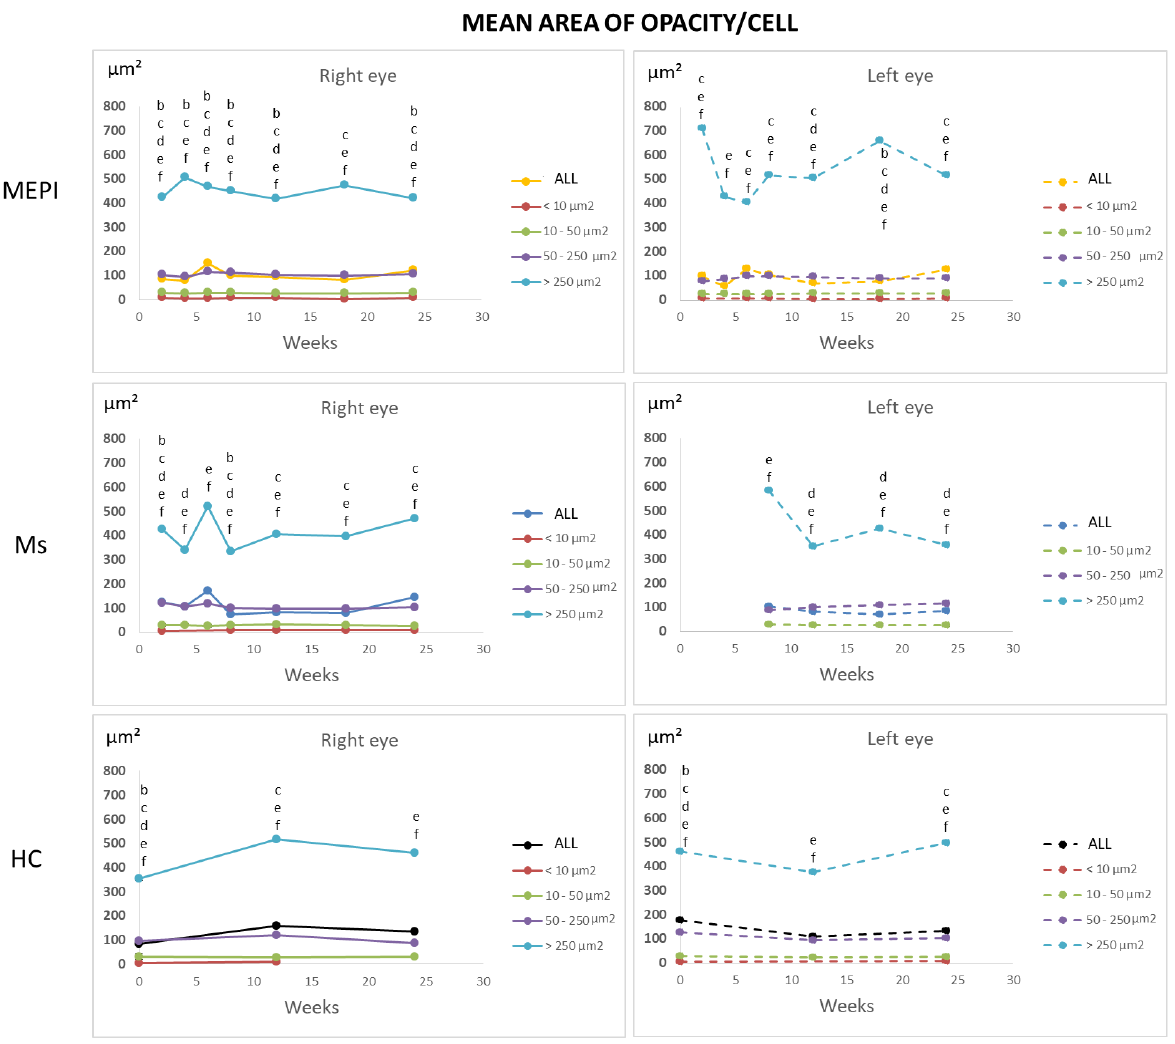
Figure 8. Cell subdivisions based on the mean area of vitreous opacities measured using OCT. Abbreviations: MEPI: model induced by sclerosing the episcleral veins; Ms: model induced by injecting microspheres into the anterior chamber; isolated cells: <10 microns 2 (group 1); non-activated cells: 10–50 microns 2 (group 2); activated cells: 50–250 microns 2 (group 3); cell complexes: >250 microns 2 (group 4). Cell populations maintain similar sizes over time, implying reliability of measurement. Complexes > 250 microns 2 undergo the greatest variations with peaks at the onset of noxa in both eyes. Statistically significant differences ( p < 0.05) were highlighted with alphabetic markers as follows: a (group 1-group 2); b (group 1-group 3); c (group 1-group 4); d (group 2-group 3); e (group 2-group 4); f (group 3-group